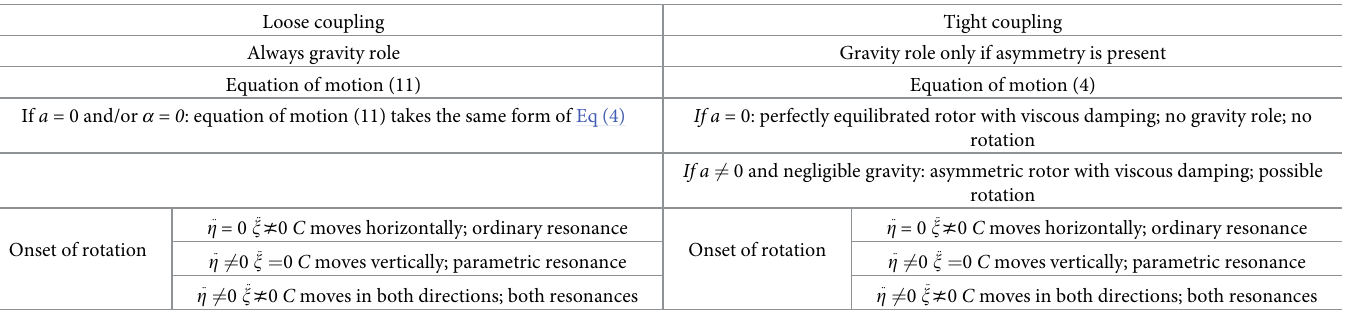
Table 1. Resume of the basic nail-propeller